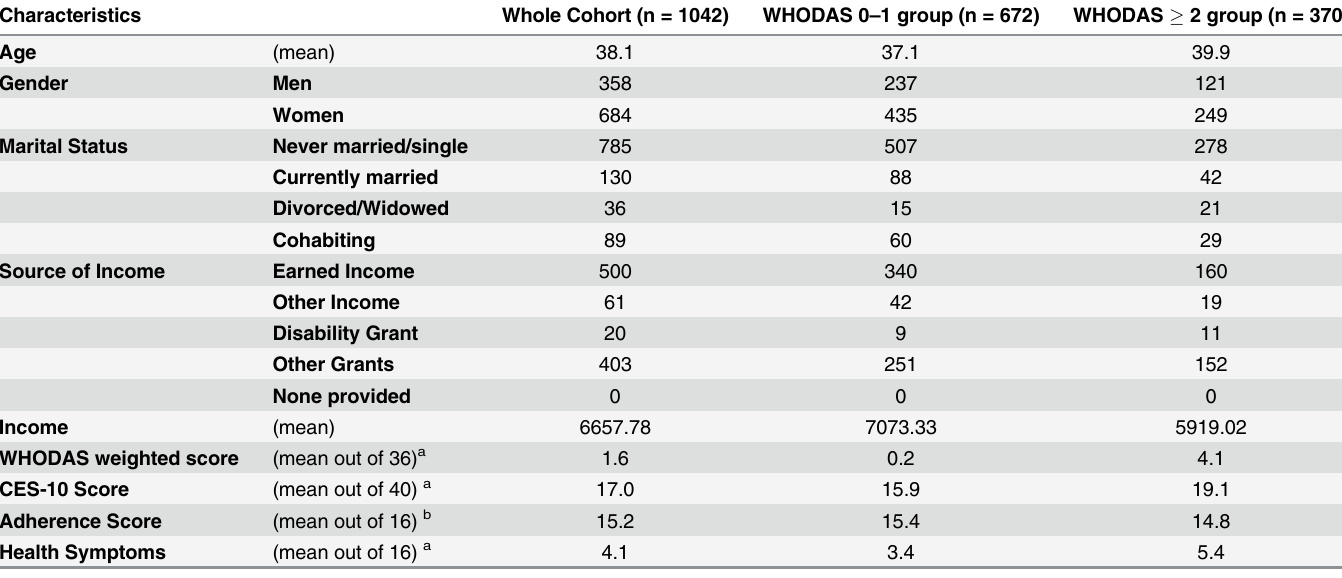
a Higher scores indicate worse health outcome. b Higher scores indicate better